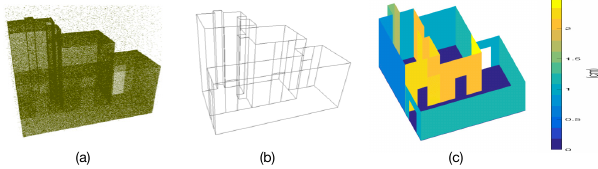
Figure 11. Accuracy evaluation: a) point clouds with σ = 10 mm Gaussian noise; b) wireframe model; c) quantitative evaluation of the reconstructed surfaces and supporting points. added with 10% Gaussian noises as shown in the left of Figure 11. The reconstruction errors are measured by the distances from points to the corresponding reconstructed surfaces. The right of Figure 11 shows the color maps of the reconstruction errors. The maximum fitting error, minimum fitting error and the average fit- ting error turned out to be 2.52cm, 0.58cm, 1.77cm,